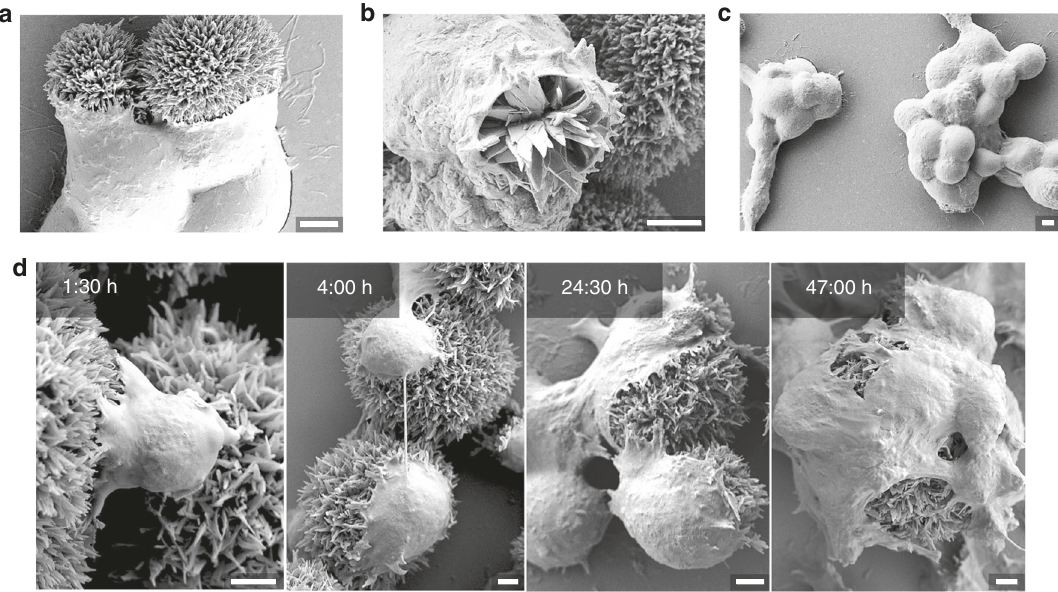
Fig. 5 SEM imaging of human embryonic kidney ( HEK ) cells cultured with quinacridone nanohedgehogs. a Close and highly conformal interfaces form after a few hours in culture. b Engulfment-like events are observable in the case of HEK cells, here a cell is imaged in the course of an endocytosis event with a nanodagger hedgehog. c HEK cells do not grow on evaporated quinacridone thin- fi lms. Here cells are cultured on substrates with hedgehogs where the entire surface, including hedgehogs, is coated with a uniform sublimated quinacridone thin fi lm, thus demonstrating that the nanostructure and not chemical nature of the substrate is critical for cell adhesion. d Interface contact between HEK cells and hedgehogs increases over cell culture time, and morphology transitions from rounded cells with a few attachment points to cells showing extensive spreading on the hedgehog structures. Scale bars = 2.5 µ